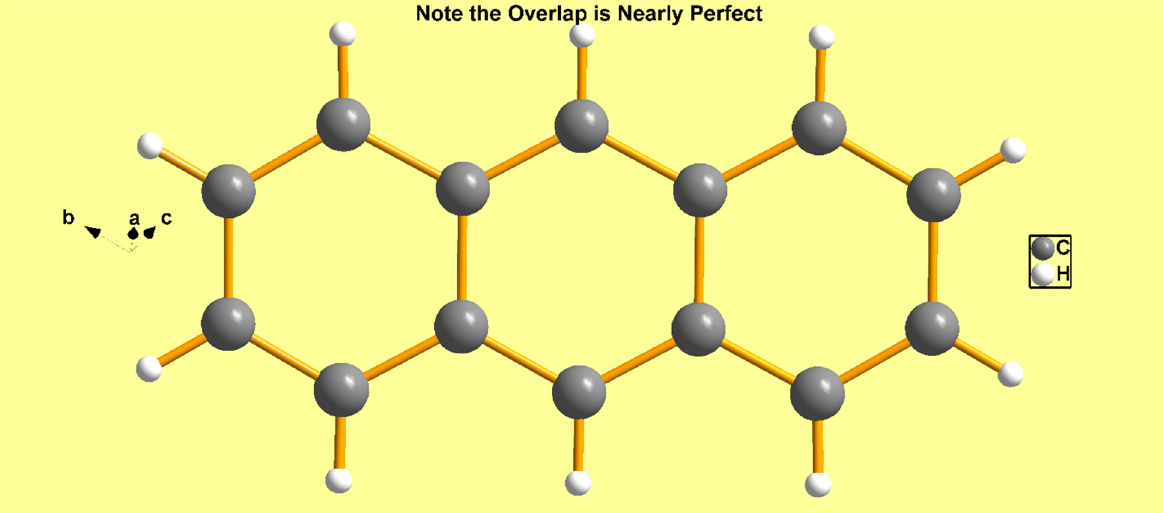
Figure 7. At this level of resolution, it is nearly impossible to determine that there are two anions plotted on top of one another. Thus, these fragments do not play any role whatsoever in determining the kryptoracemic nature of these crystals; a role relegated to the cationic species described next in Figure 8.